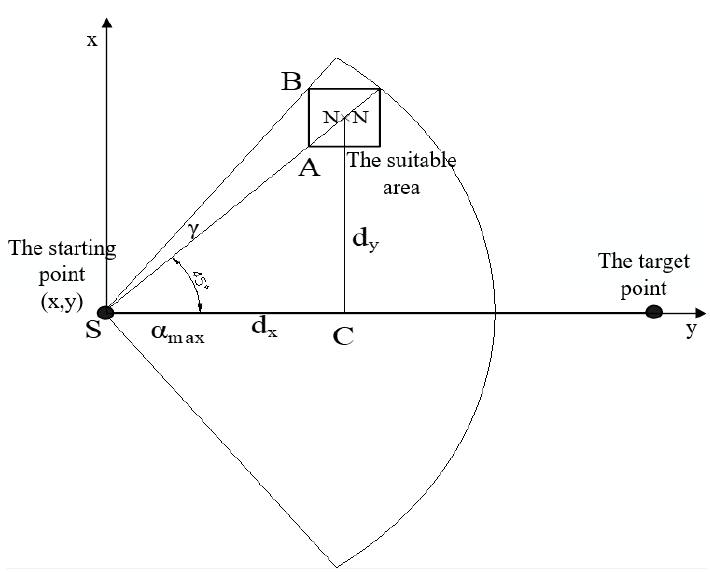
α . Figure 8. The method to calculate α max